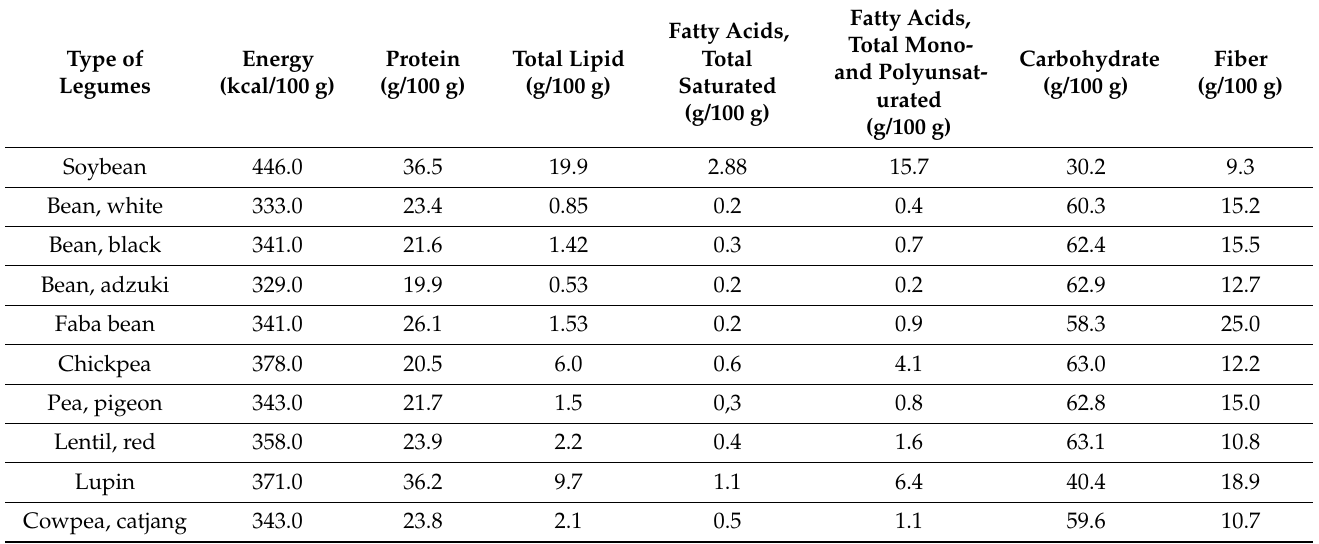
Table 2. The nutritional value of selected raw legumes, according to FoodData Central Search Results by U.S. Department of Agriculture